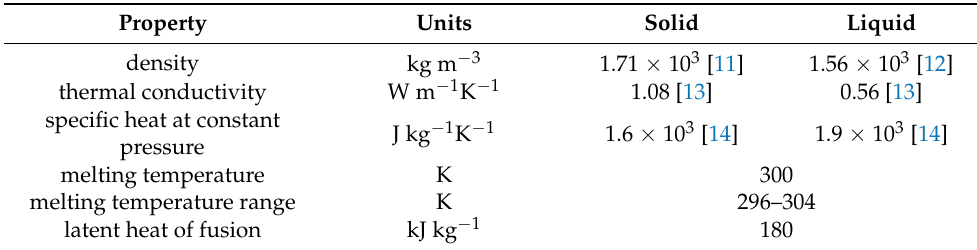
Table 3. Transport properties of